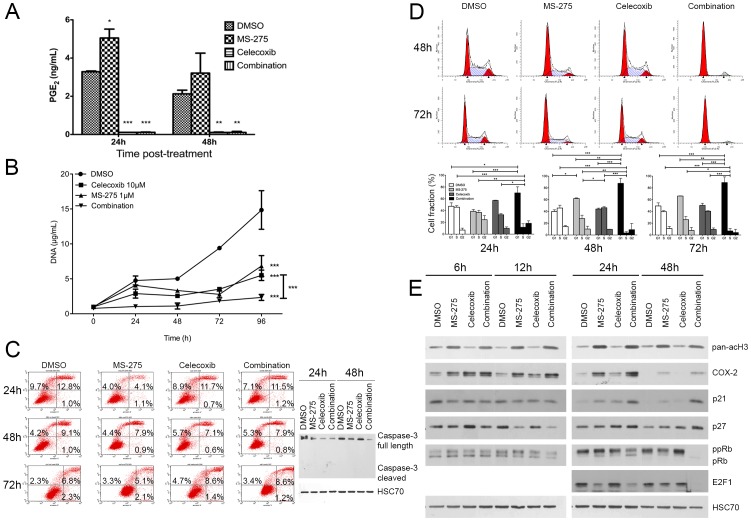
Effect of HDAC and COX-2 coinhibition in BxPC-3 cells.(A) ELISA assay of PGE2 in cell culture media 24h and 48h after 1 µM MS-275 and 10 µM celecoxib treatment. (B) Time-dependent effects of MS-275 and celecoxib on cell growth. (C) Time-dependent effects of 1 µM MS-275 and 10 µM celecoxib on apoptotic cell ratio by annexin V/PI flow cytometry and on caspase-3 cleavage. (D) Time-dependent effects of 1 µM MS-275 and 10 µM celecoxib on cell cycle by PI incorporation. (E) Western-blot detection of p21, p27, pRb ppRb and E2F1 in 20 µg BxPC-3 proteins 6 to 48h after 1 µM MS-275 and 10 µM celecoxib treatment. HSC70 was used as a loading control. Results are expressed as mean ± s.d., ***P<.001, **P<.01, *P<.05 versus DMSO or indicated conditions. n≥3 in each condition.